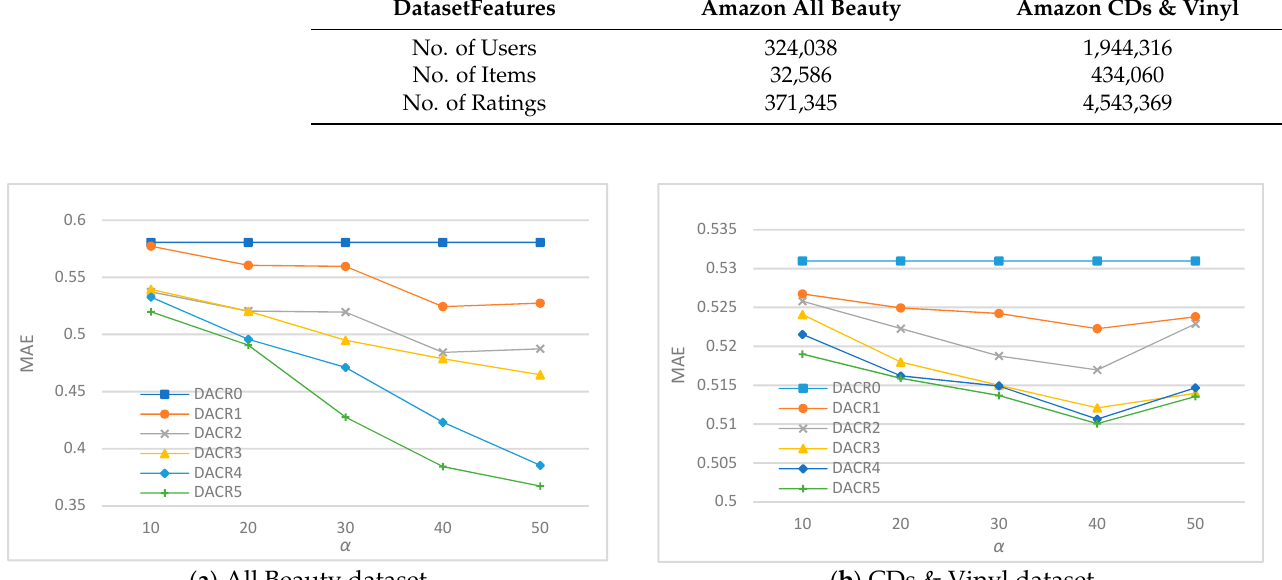
Figure 8. The performance of the proposed recommender for two Amazon datasets under different DACR settings.